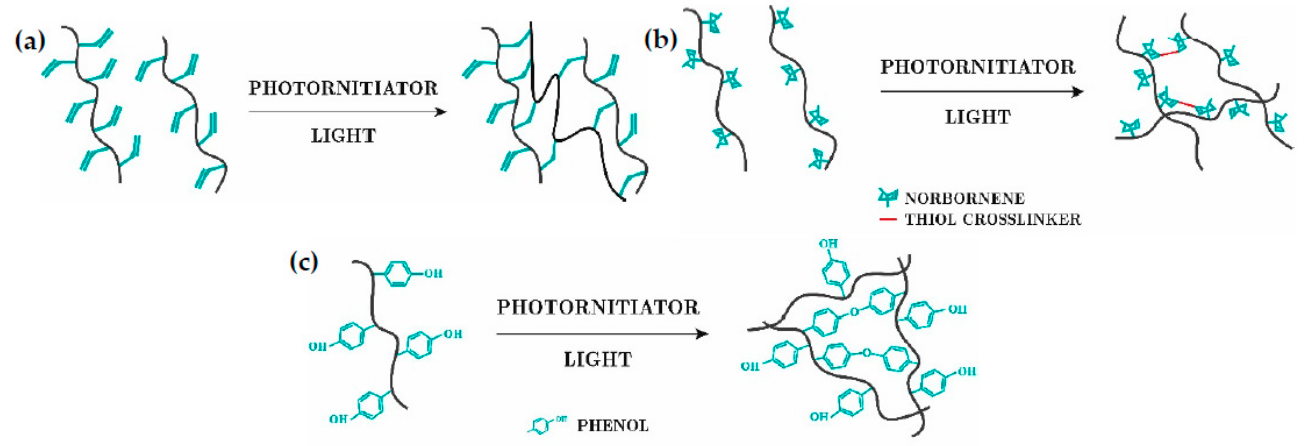
Figure 2. Photo-induced cross-linking. ( a ) Free-radical chain. ( b ) Thiol-ene photo. ( c ) Photomediated redox reaction.